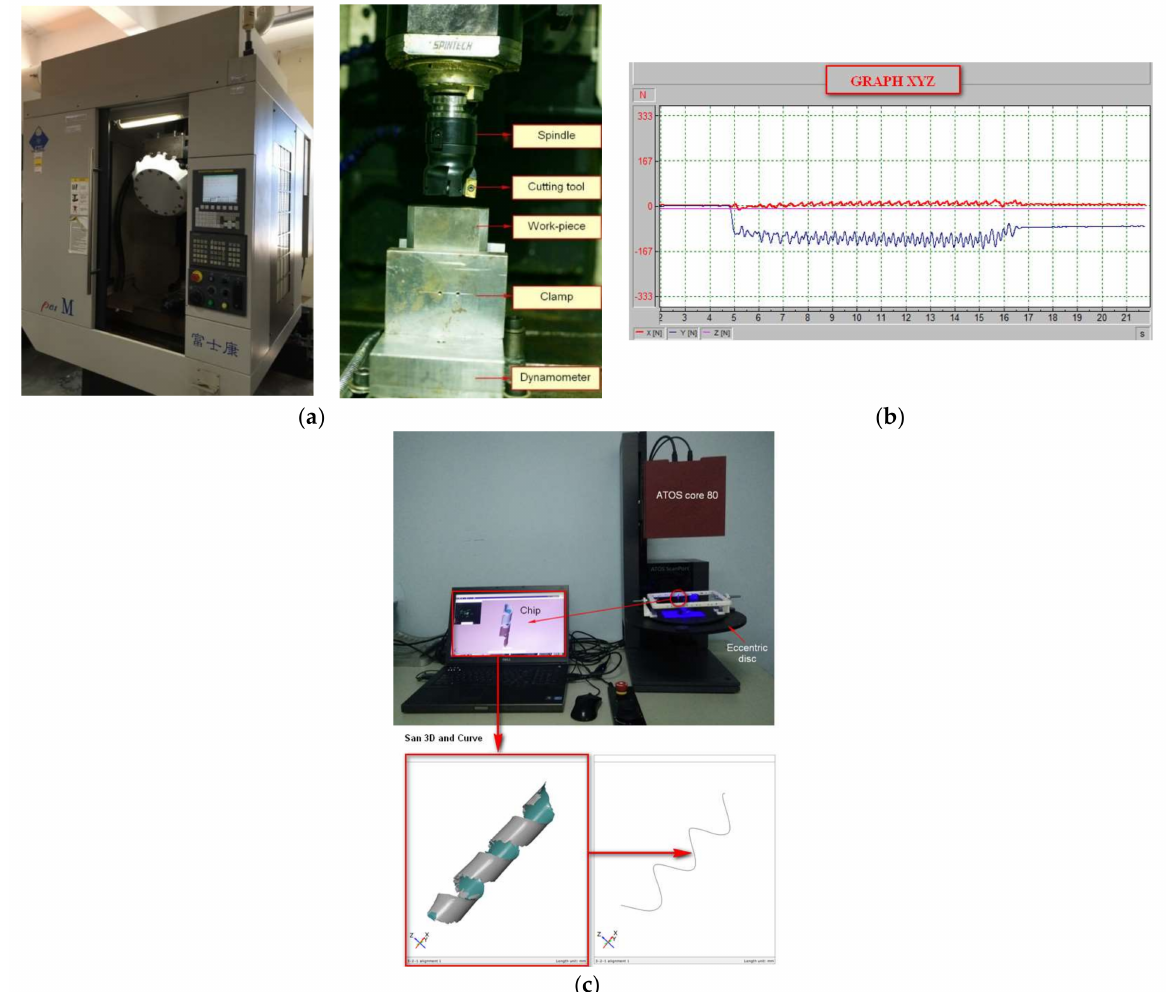
Figure 3. Experimental setup ( a ), cutting forces displayed on DASYlab software ( b ), and chip length determination by 3D scanning ( c